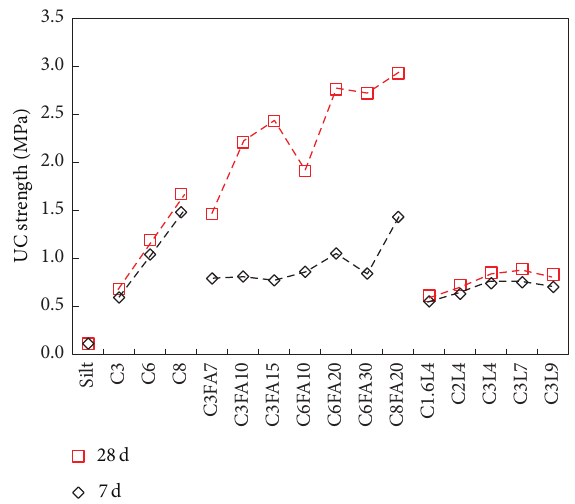
Figure 4: UC strength of stabilized samples without frost actions.